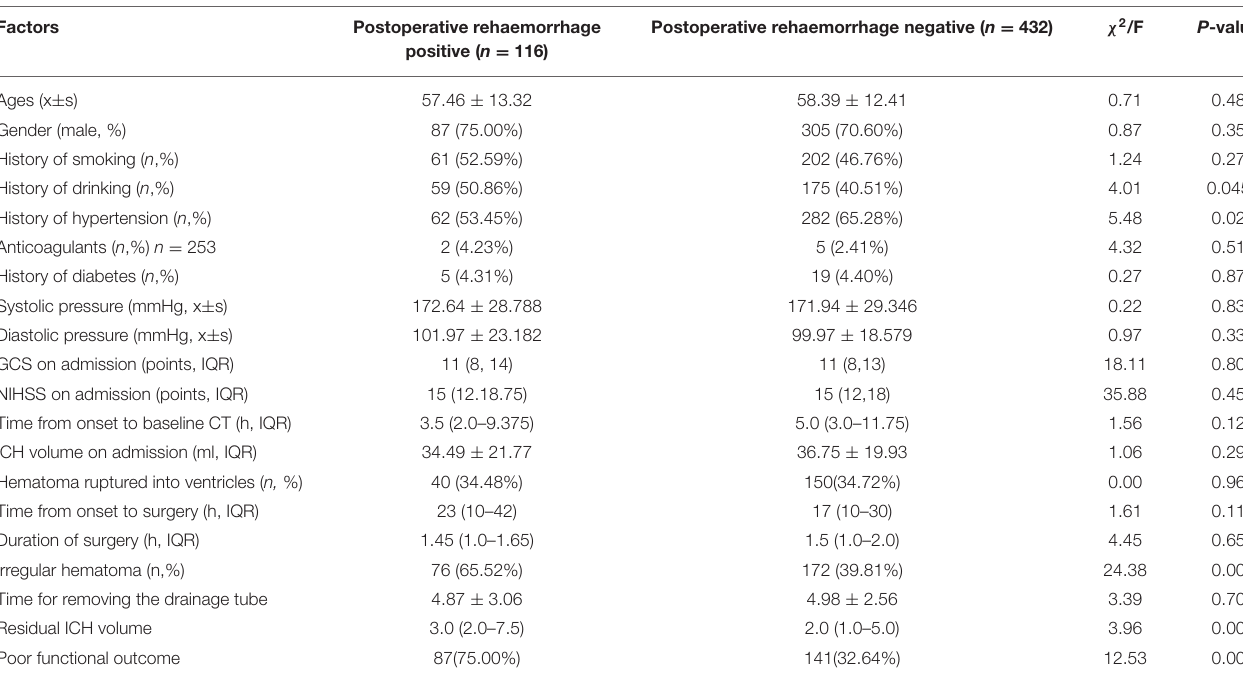
TABLE 3 | Univariate analysis of predictors related to postoperative rehaemorrhage who underwent stereotactic minimally invasive surgery.